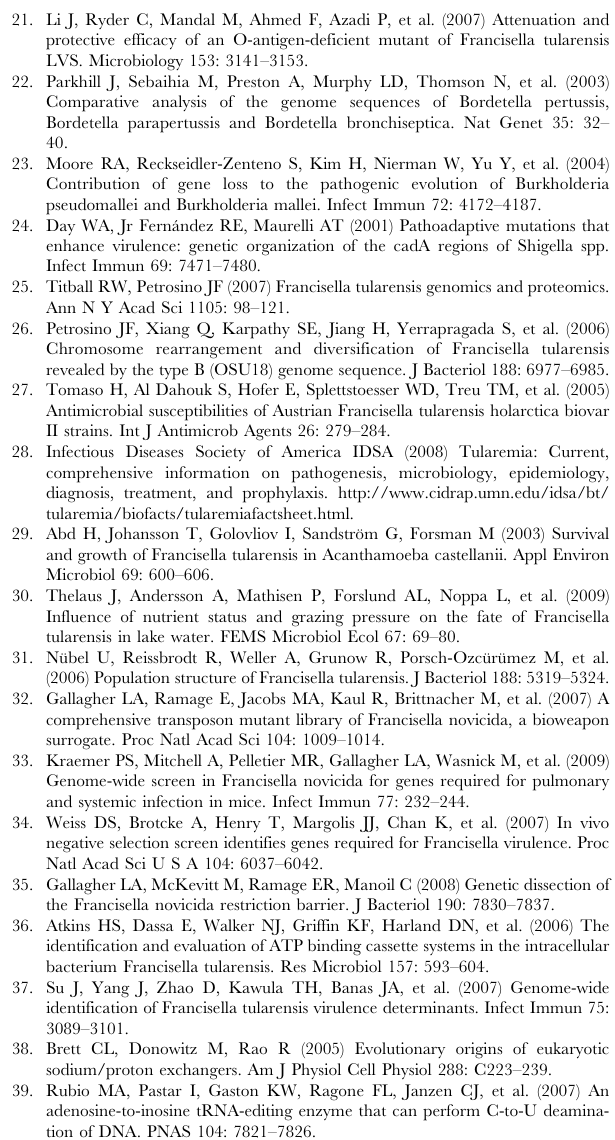
Table S2 Summary of genes identified as candidates for mediating pathogenicity in F. tularensis subsp. tularensis (Type A), F. tularensis subsp. holarctica (Type B), and F. tularensis subsp. novicida by previous